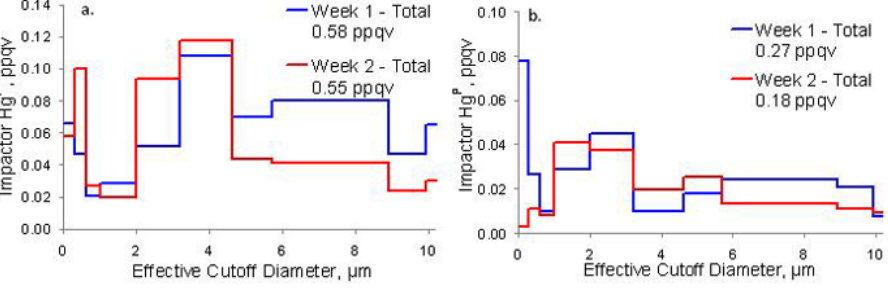
Fig. 6. Size Distribution of Hg P at Appledore Island (a) and Thompson Farm (b) during summer 2010 showing similar distributions of Hg P at both sites with Appledore Island exhibiting twice as much total Hg P .